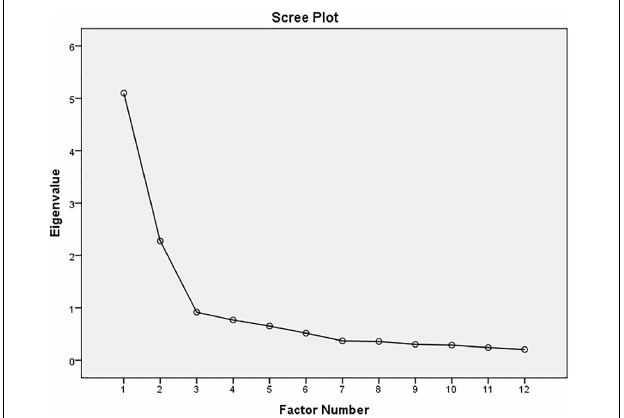
FIGURE 1 | Scree plot for the TQ